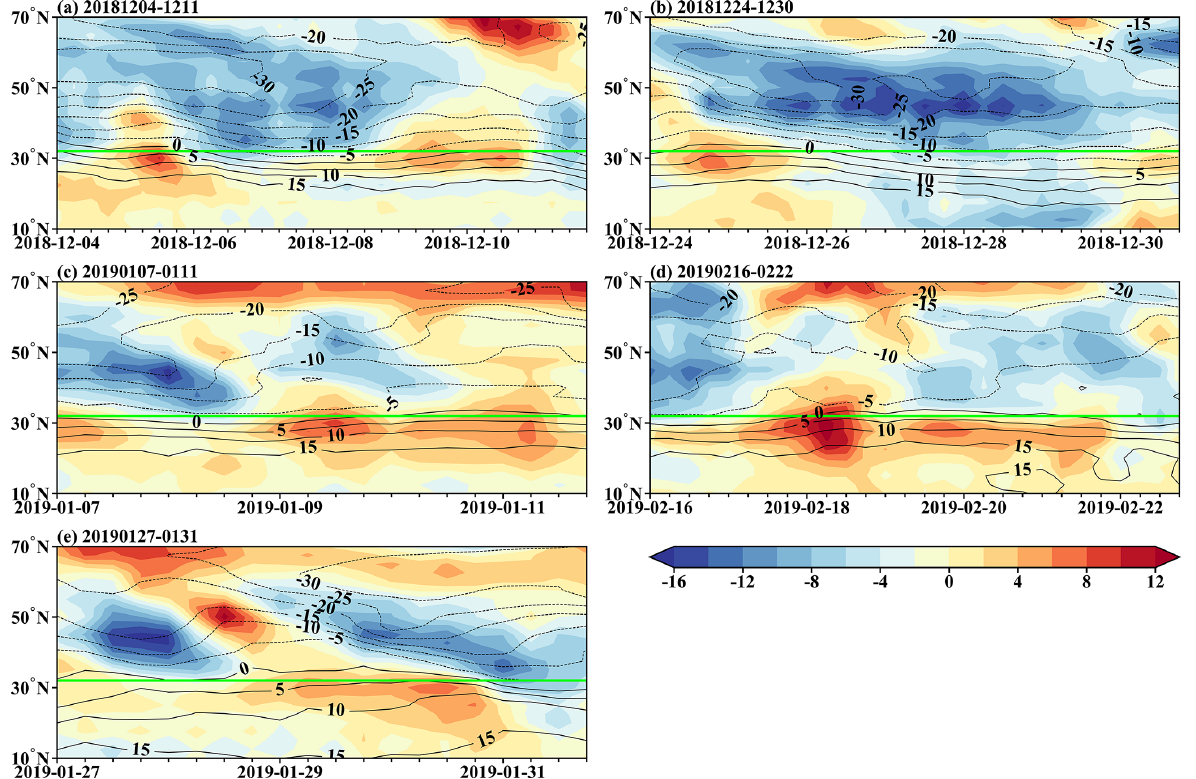
Figure 3. Latitude–time cross section of the meridional wind component (shading; units in meters per second; hereafter ms − 1 ) and tem- perature (contour; units in degrees Celsius) at 850hPa along 120 ◦ E. The horizontal green lines indicate the latitude of the sampling site at Nanjing (32.12 ◦